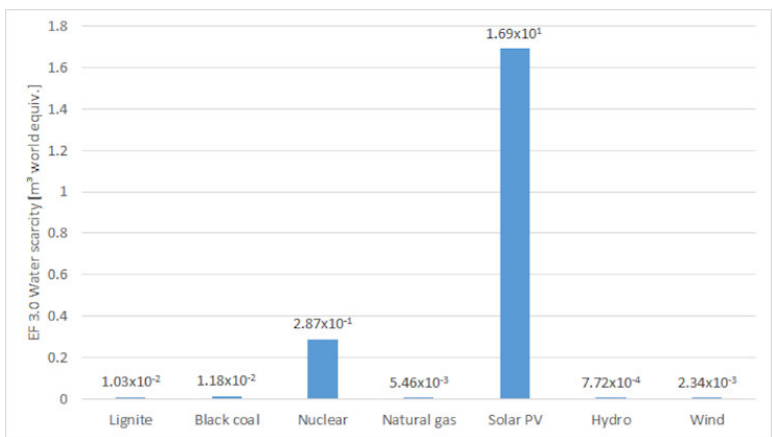
Figure 10. Environmental impacts of selected energy sources on the particulate matter category. The results relate to 1 kWh of electricity supplied to the grid. The results are expressed in the number of disease